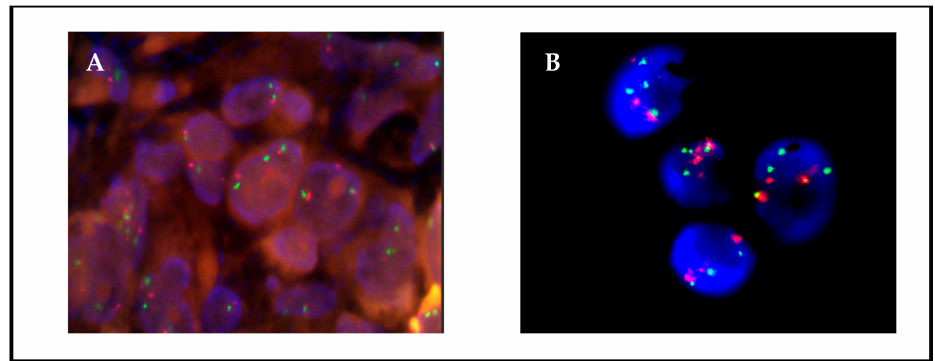
Figure 1. FISH MET images on ( A ) FFPE tissue and ( B ) a paired cell culture from patient 12. Since the patient was in progression, the possible presence of MET amplification was determined by FISH. Both tissue and culture samples were negative, with an average of 3 green signals corresponding to MET , a ratio of 1:1 to CEN7, and 0% of cells with >5 copies. Culture preparation presents less background and